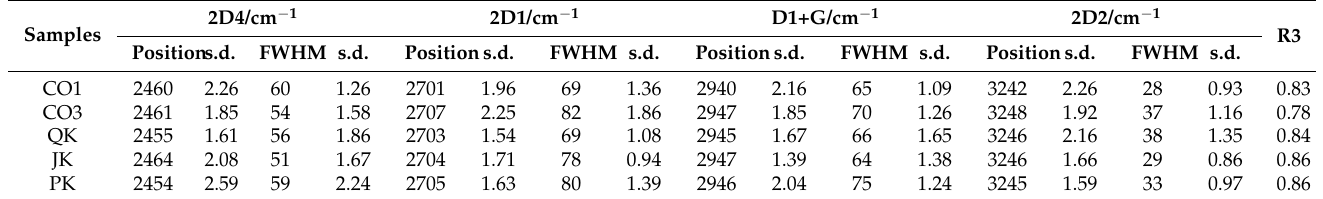
Table 3. Second-order Raman spectral parameters of graphite microcrystals derived from peak